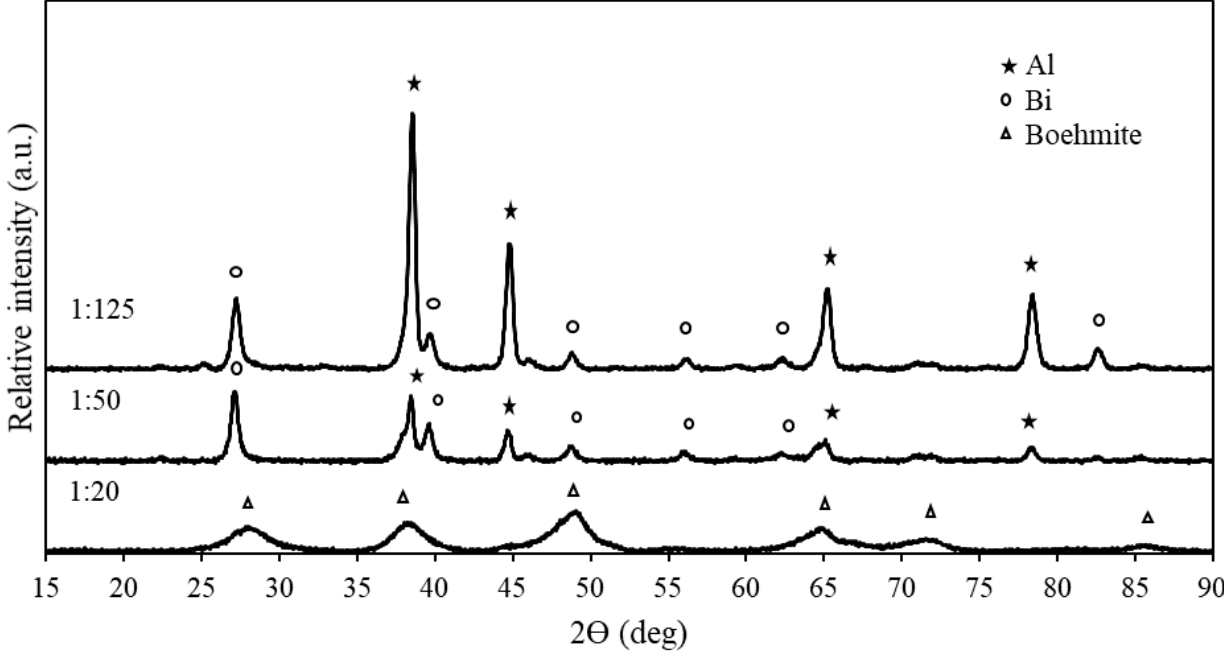
Figure 8. Hydrolysis residues of ternary composite Al-9.25% Bi-0.75% Ni at different mass ratios.